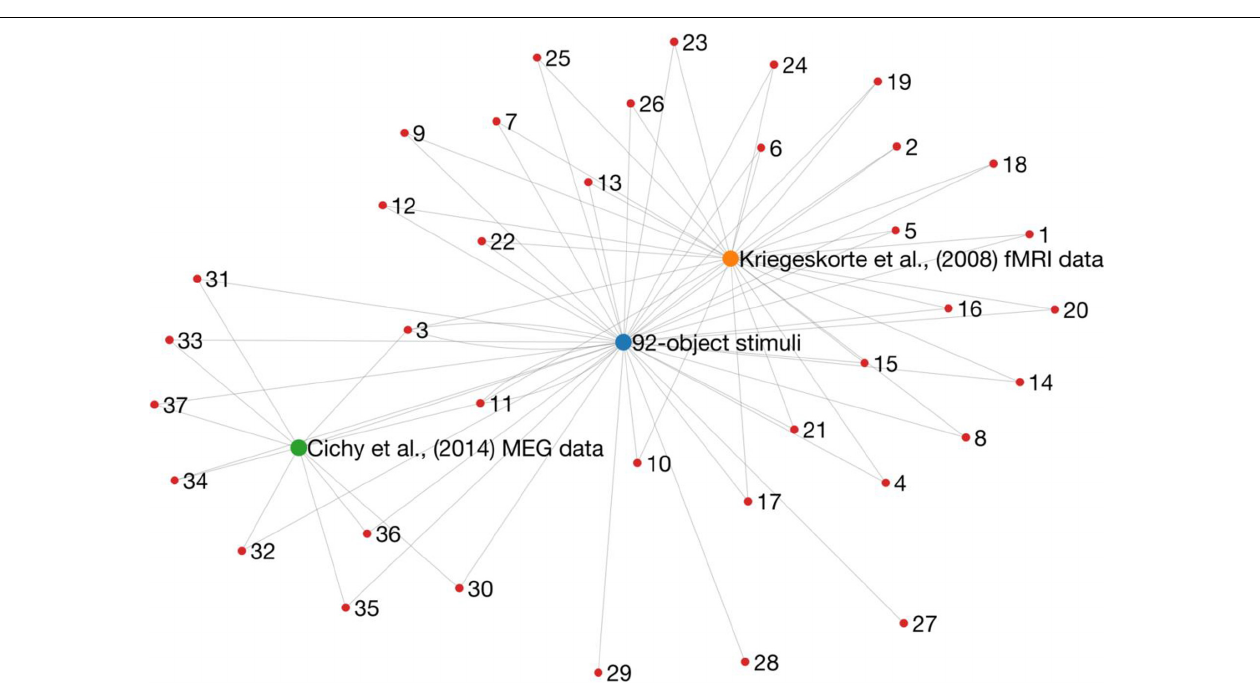
FIGURE 2 | A graph representation of research outputs (nodes) that re-used (edges) the same dataset or stimuli from two influential papers (larger nodes). Importantly, this is not intended to question or refute the findings of any of these studies, but rather to point to a potential issue of generalisability in the literature. These data were obtained by going through Scopus citation lists, and therefore it is likely that the graph is not